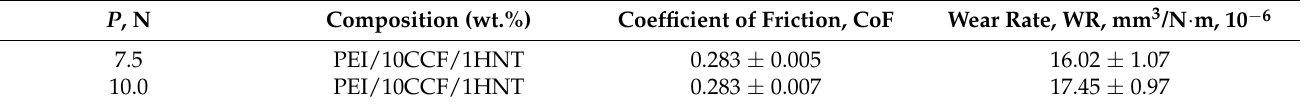
Table 8. The tribological properties of the PEI-based nanocomposites. Point tribological contact.